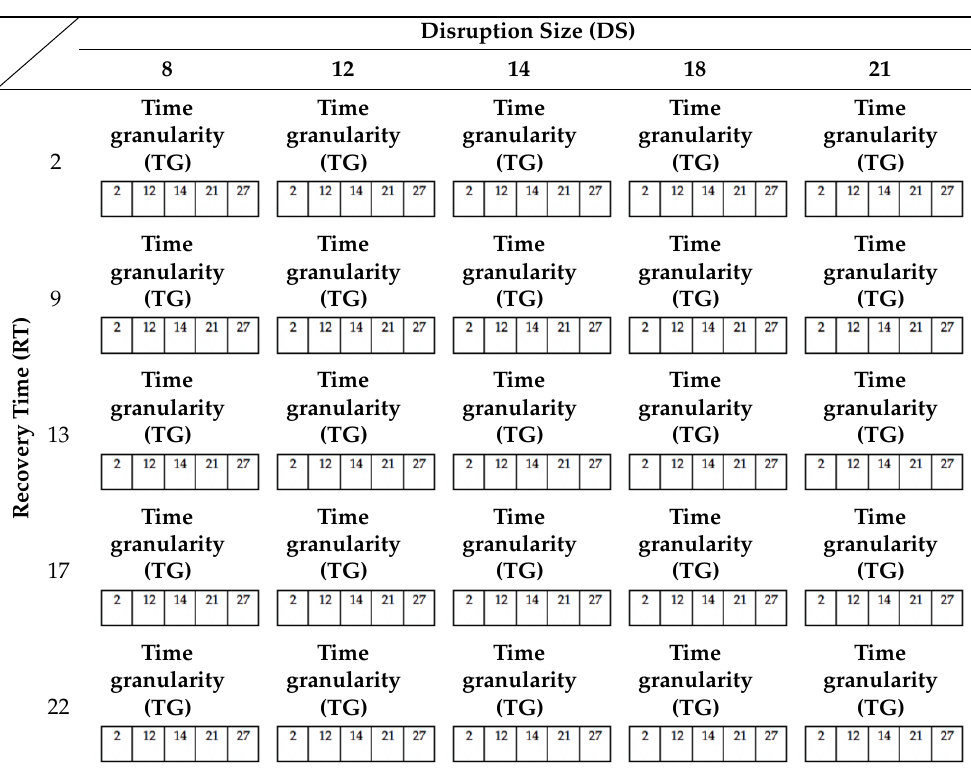
Table 1. 5 × 5 × 5 hypercube full-factorial layout achieved via LHS. Experimental factors included time granularity (TG), recovery time (RT), and disruption size (DS).